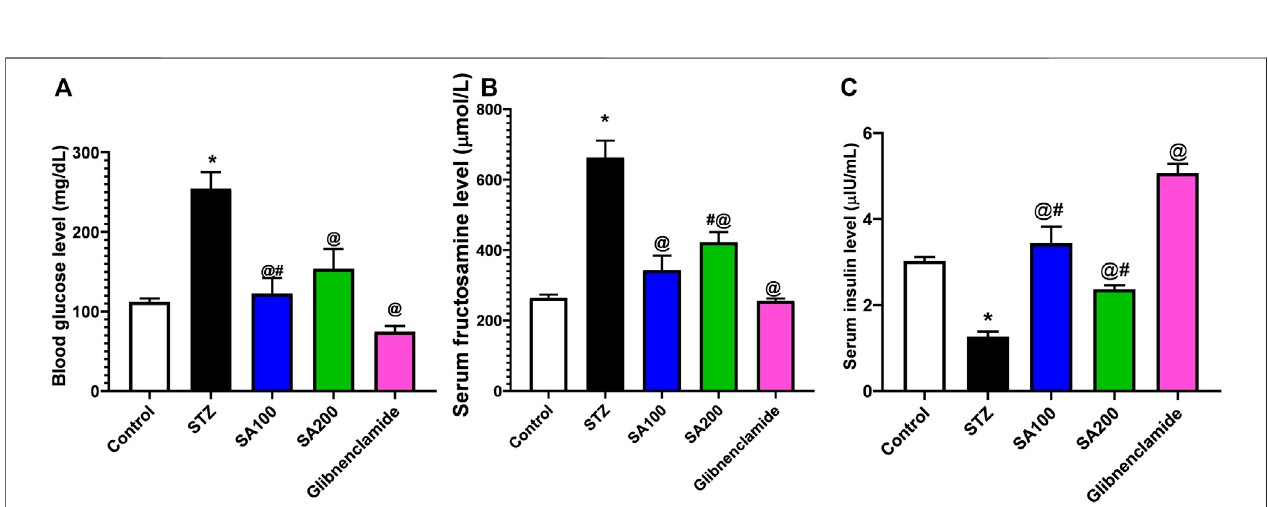
FIGURE 2 | Results from the oral administration of the leaf extract of S. aqueum (SA) on the levels of (A) blood glucose (B) serum fructosamine (C) serum insulin in STZ-induced diabetic rats. Results are presented as mean ± SEM. *Signi fi cant difference related to the normal control group, @ related to STZ diabetic rats, # related to reference drug group, glibenclamide, at p < 0.05 by One-Way ANOVA and Tukey ’ s post hoc test, n (cid:2) 6.